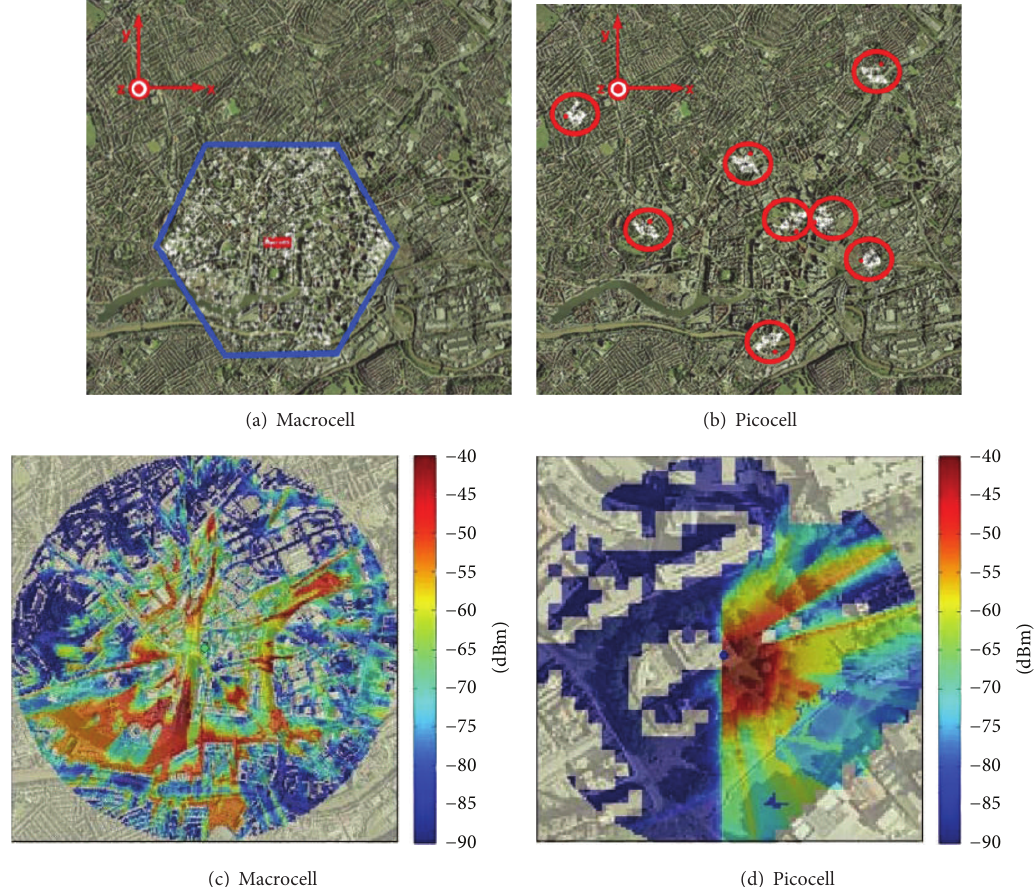
Figure 5: Examples of HetNet scenario (a) and (b) and the coverage map for (c) macrocell and (d) picocell.